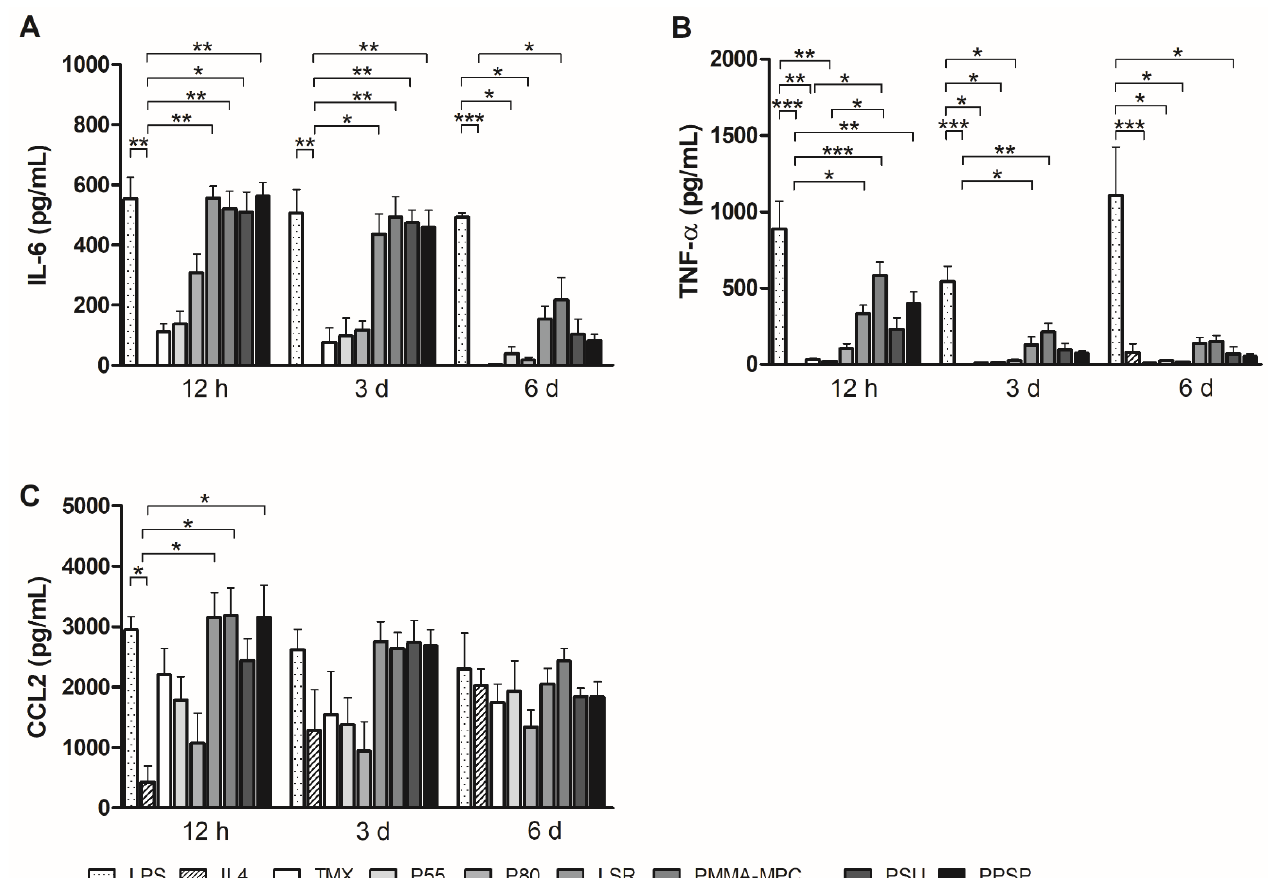
Figure 4. Unmodified and modified liquid silicone rubber (LSR) stimulate macrophages to secrete pro-inflammatory cytokines. Cytokine production of ( A ) IL6 ( B ) TNF α ( C ) CCL2 was measured by using enzyme-linked immunosorbent assay. Data are represented as mean + SE Mean of six independent experiments. Significant results are indicated as * p < 0.05; ** p < 0.01; and *** p < 0.001.